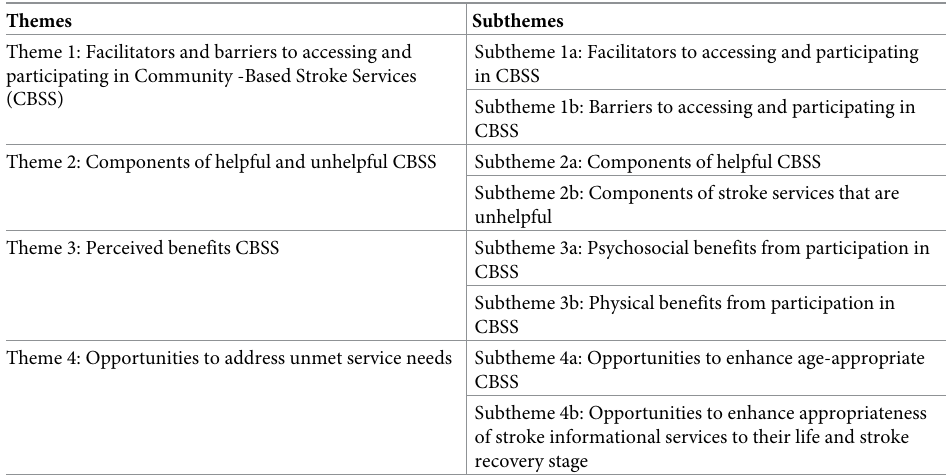
Table 4. Themes and